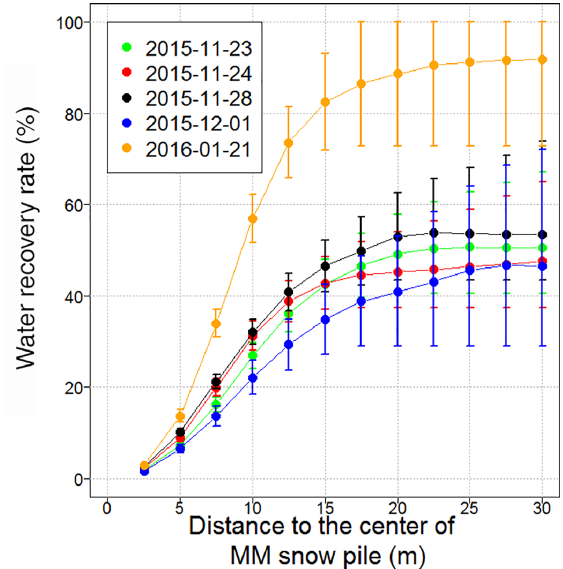
Figure 5. The water recovery rate (%) within concentric circles around the center of the MM snow pile. The larger the circle the larger the uncertainty on the snow volume and therefore the larger the uncertainty on the water recovery